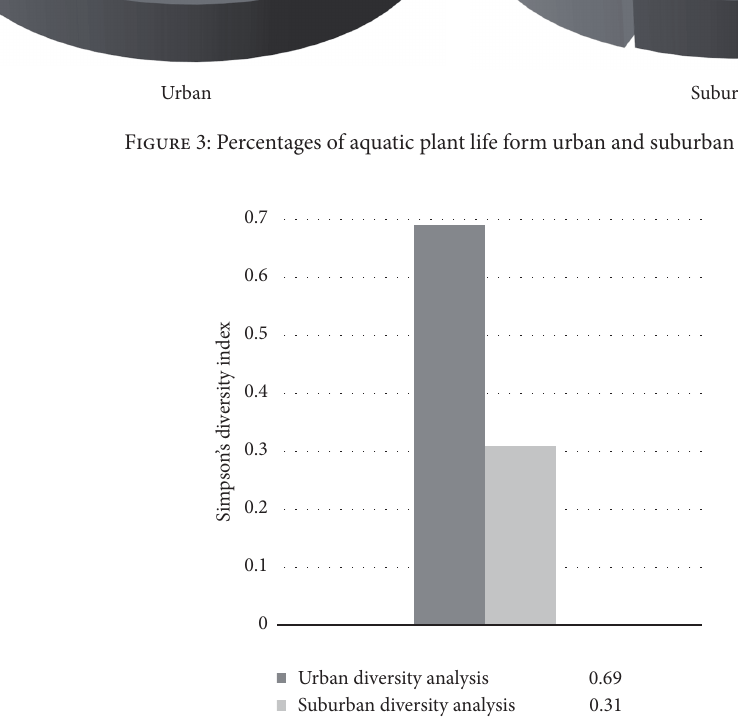
Figure 4: Urban and suburban diversity